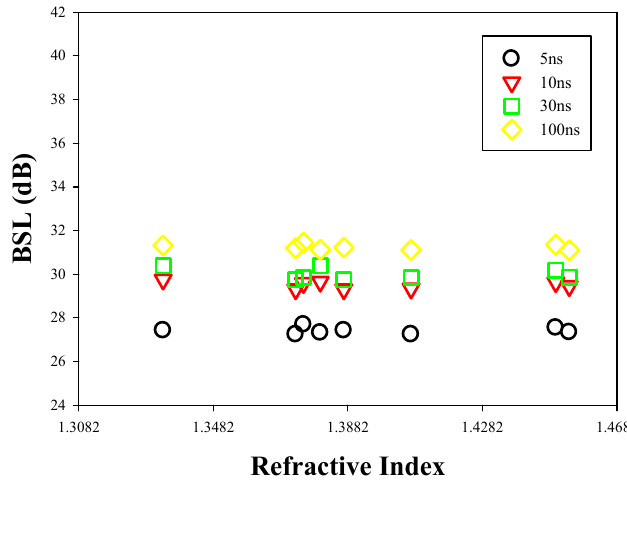
Figure 6. Output BLS levels from the OTDR traces under various testing liquid chemicals when the fiber sensor head with irregular